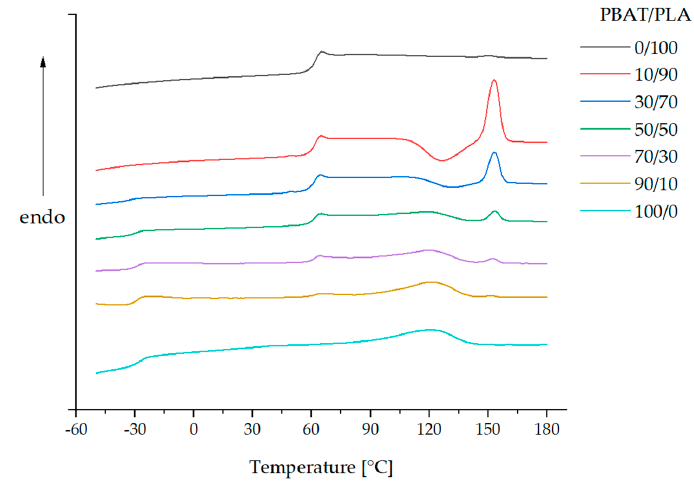
Figure 2. DSC thermograms: the second heating curves of PBAT/PLA blends.